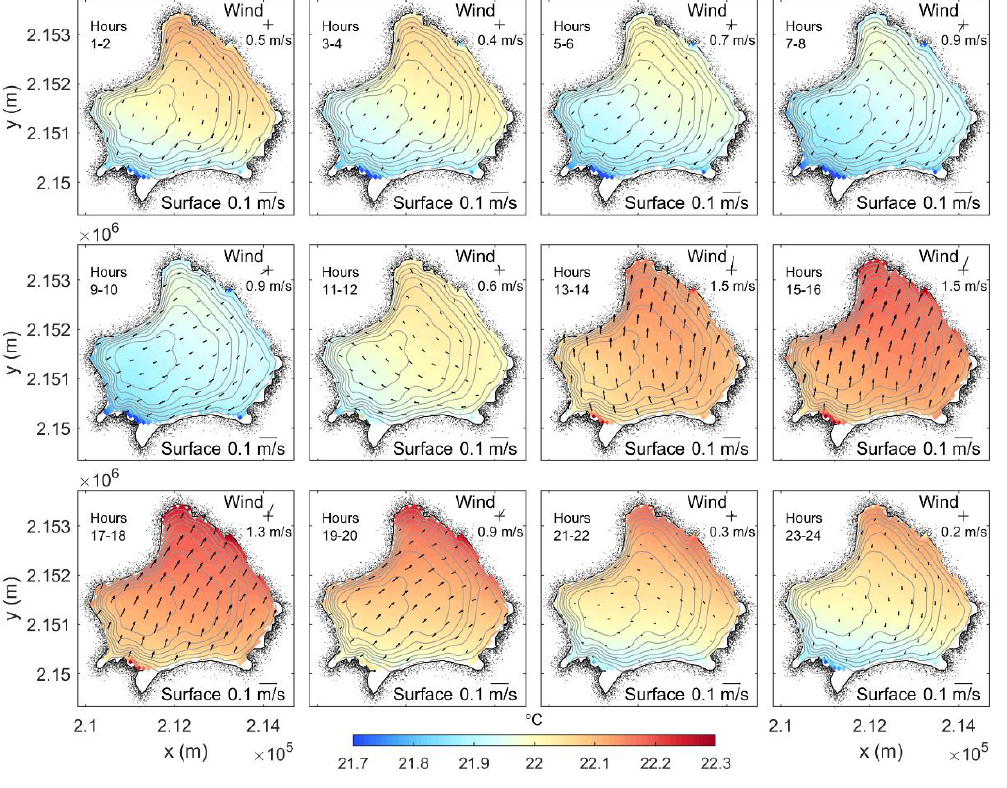
Figure 17. The 2-h composite average of the daily general thermodynamics at the surface of Lake Zirahuén. The composites of the simulated surface current velocity (vectors), water temperature (color), and wind speed (vector at the upper right corner of every axes). The composites comprise averaged periods of 2 h, that is, the numerical results obtained for every hour each day were averaged.